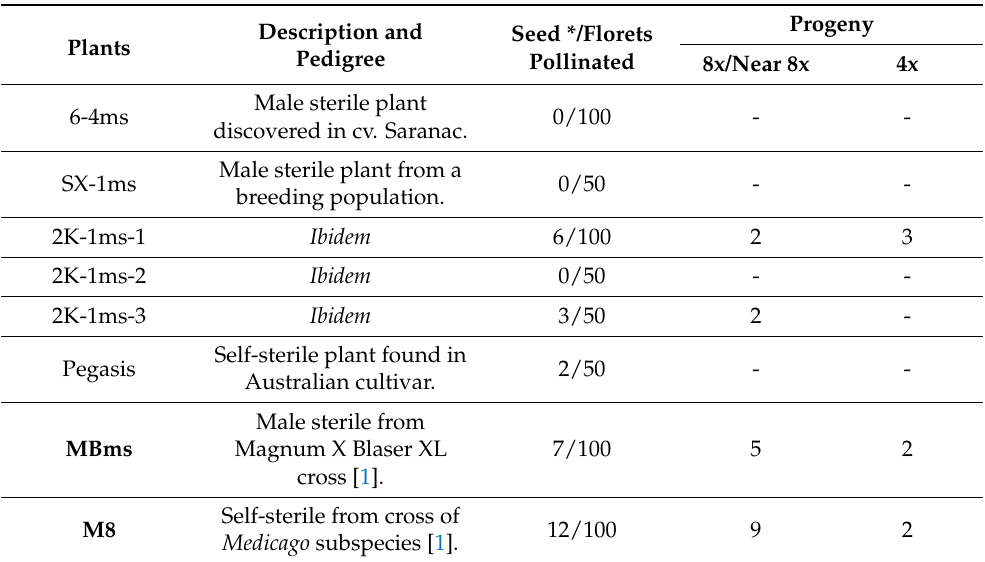
Table 1. Alfalfa seed parents tested for 2n eggs with pollen from 8x alfalfa; a 4x X 8x cross. Bold lettering indicates plants that produced hybrids with M. arborea in an earlier study [1].